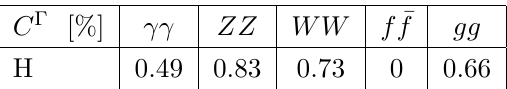
Table 2 . Coe(cid:14)cients parametrizing the corrections to the Higgs partial widths due to loops in- volving the Higgs self-coupling (see eq. (A.14)) [6].